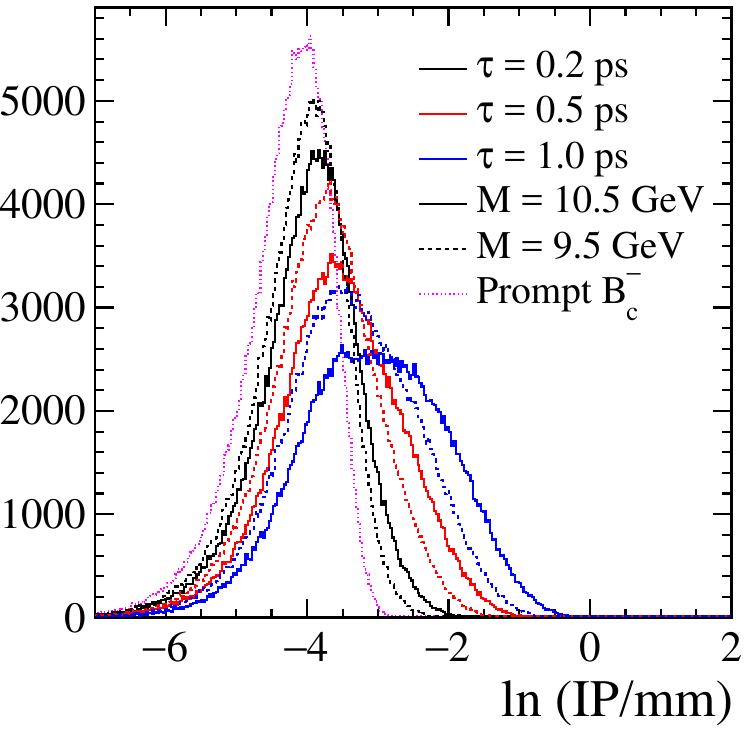
Figure 4 . IP distributions obtained from simpli(cid:12)ed simulations for di(cid:11)erent bbx hadron masses (and thus Q values) and